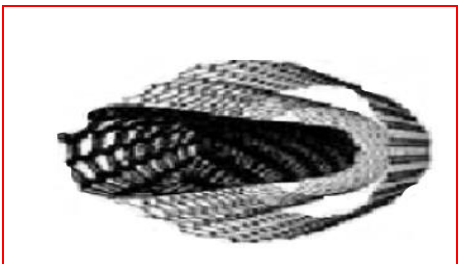
Fig. 1: Multi-walled carbon nanotube